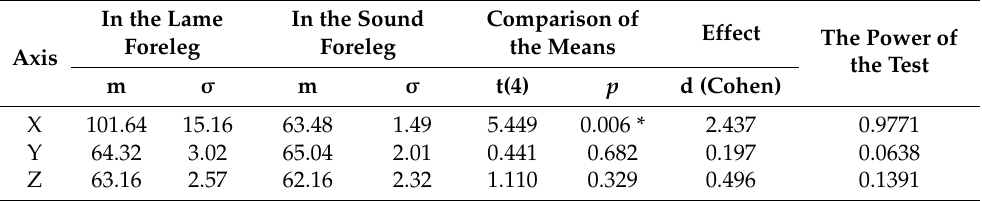
Table 3. Comparison between the mean number of impulses recorded on the accelerometers’ axes for the five assessed steps in the lame and sound contralateral foreleg of the studied horses ( n =